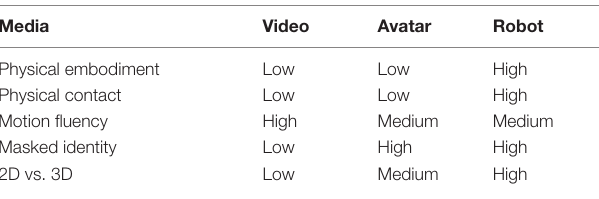
TaBle 1 | a review of features across